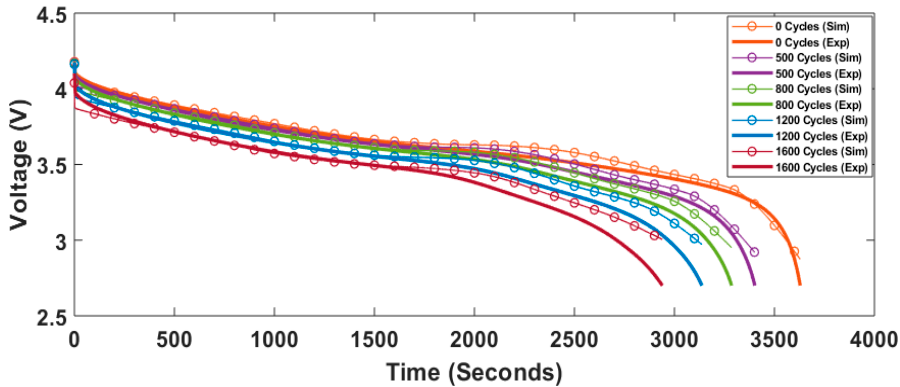
Figure 3. Comparison between simulated and experimental cell discharge voltages with different aging intervals.